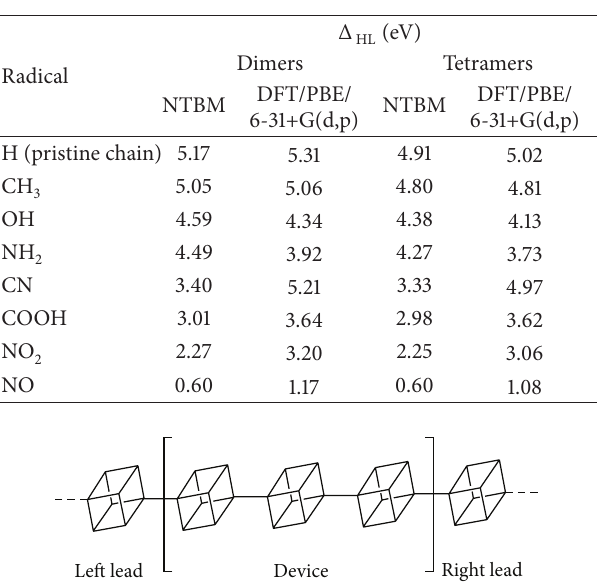
Table 1: HOMO-LUMO gaps Δ HL for various cubane-based oligomers constructed from two and four fragments.